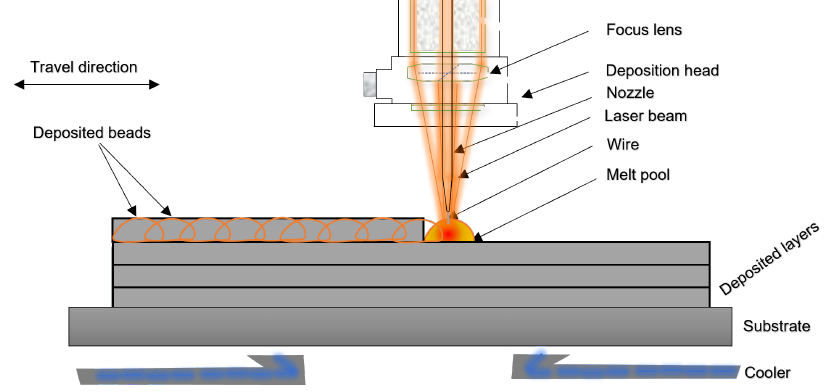
Figure 1. Schematic diagram for bead deposition process in the